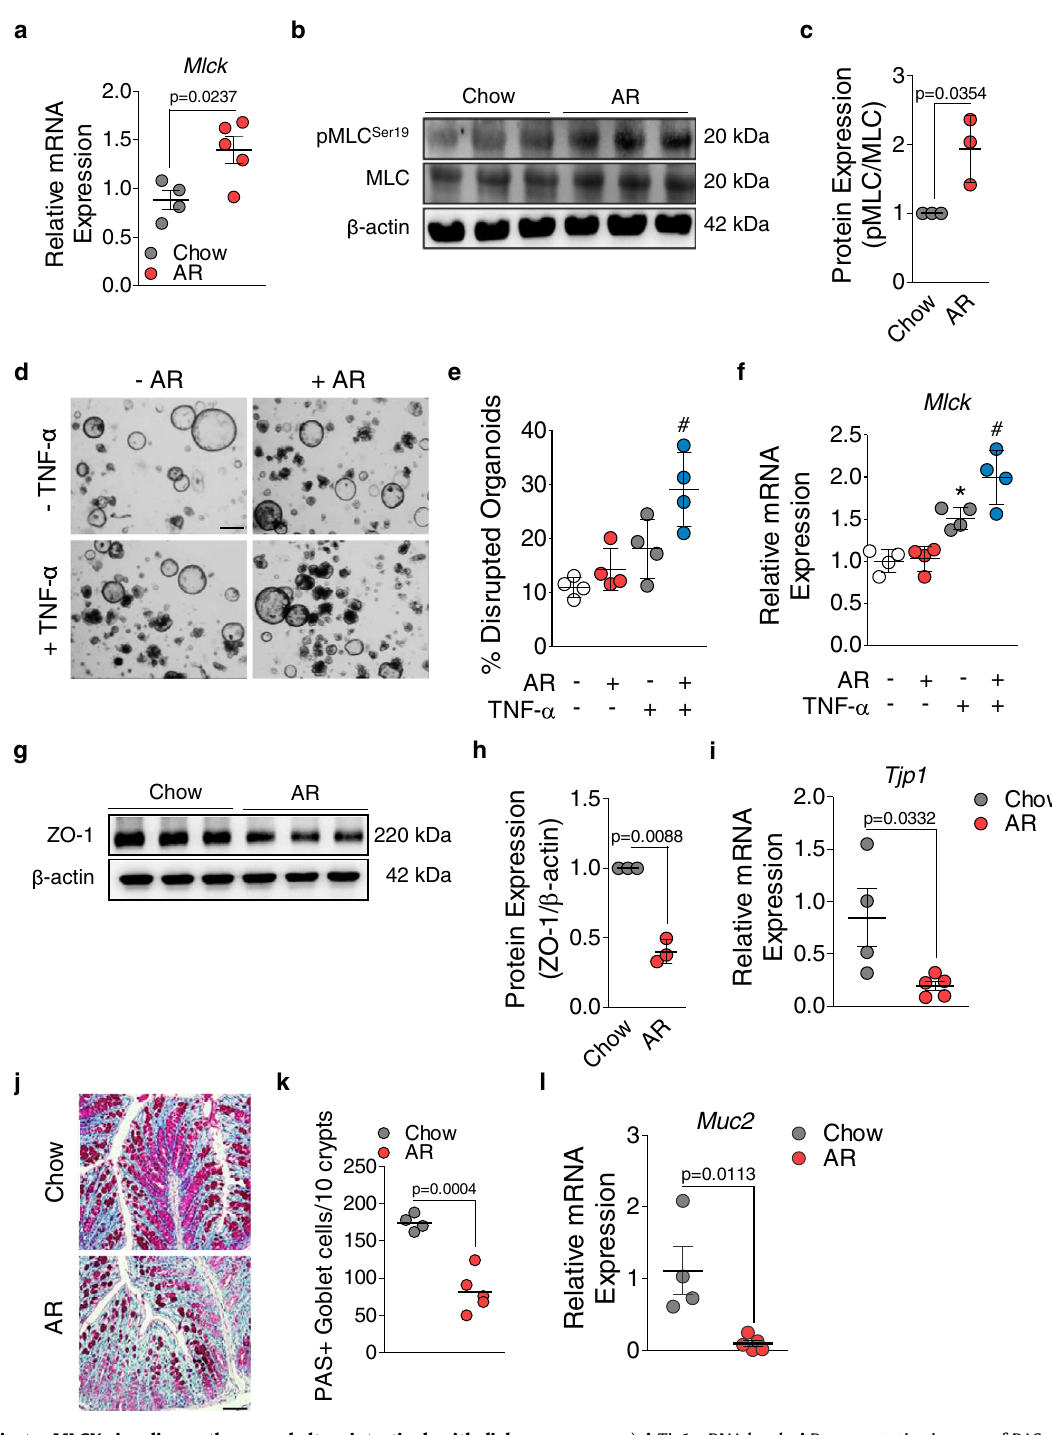
Fig. 4 | AR activates MLCK signaling pathway and alters intestinal epithelial barrierfunctioninnaïveC57BL/6miceandmurineintestinalorganoids.a Mlck mRNAlevels. b RepresentativewesternblotanalysisofpMLC Ser19 ,MLC,and β -actin. Uncropped blots are provided in the Source Data. c Relative densitometry(pMLC/ MLC) ( n =3 mice/group). d Representative bright fi eld (BF) images of